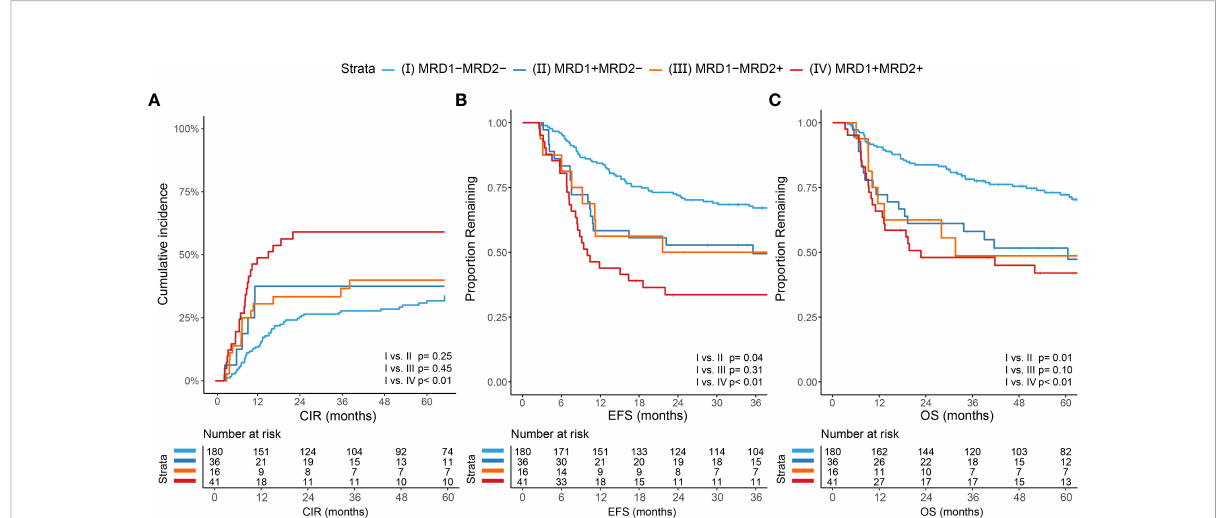
FIGURE 4 Cumulative incidence of relapse, event-free survival and overall survival compared for four groups based on combined MRD status of after cycle 1 and cycle 2. Four different groups were made based on the MRD status at time point after cycle 1 and cycle 2: (I) MRD negative at both time points (MRD1-MRD2-); (II) MRD-positive after cycle 1 and MRD-negative after cycle 2 (MRD1+MRD2-); (III) MRD-negative after cycle 1 and MRD-positive after cycle 2 (MRD1-MRD2+); and (IV) MRD-positive at both time points (MRD1+MRD2+). (A) Cumulative incidence of relapse (CIR) between the four groups with only a signi fi cant difference between MRD1-MRD2-(I) and MRD1+MRD2+(IV) (p<0.001). (B) Event-free survival (EFS) difference of the four groups with a signi fi cant difference between group (I) and group (IV) (p<0.001), but also between group (I) and group (II) (p=0.044). (C) Overall survival (OS) was also signi fi cantly different both between group (I) and group (IV) (p=0.001), and between group (I) and group (II)